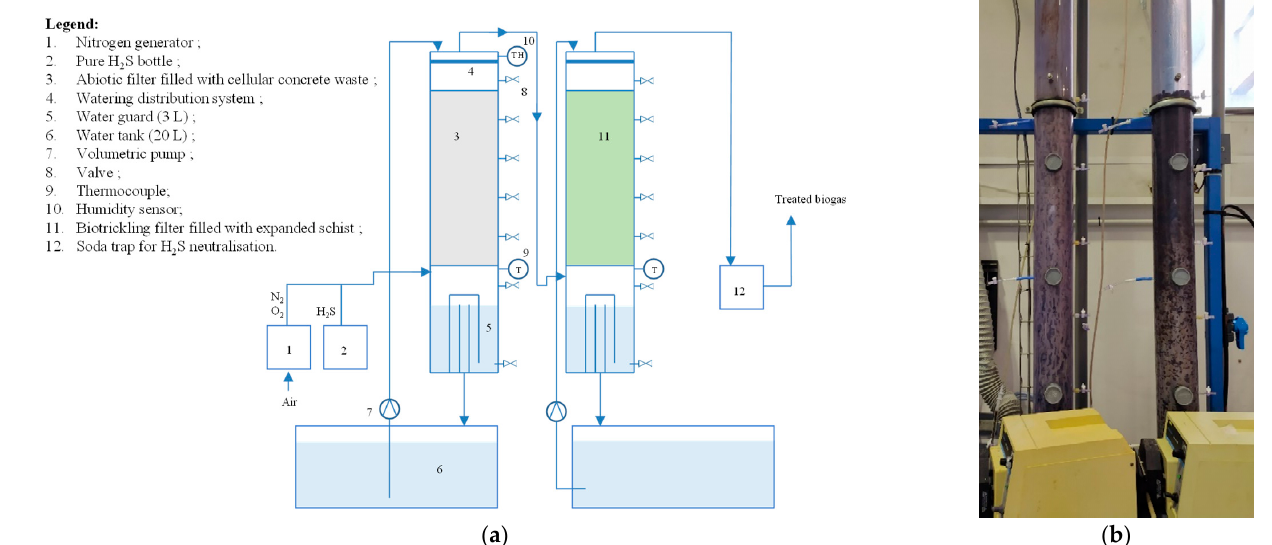
Figure 2. Experimental setup; ( a ) flow sheet; ( b ) picture of experimental columns (left: first stage, abiotic filter; right: second stage, biotrickling filter). Table 2. Parameters used in this study.